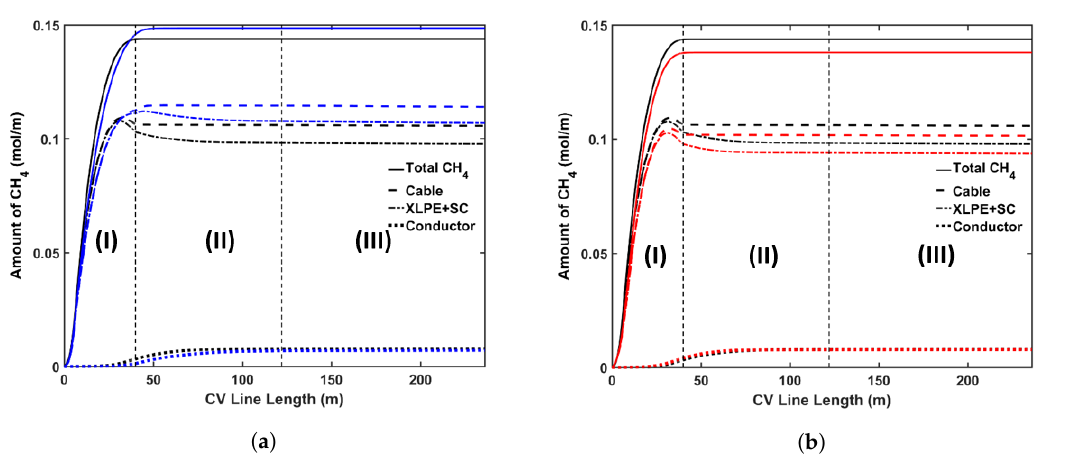
Figure 11. Axial CH 4 concentration profile across CV line for curing temperature study. The black line represents base case, blue line in ( a ) represents Case 1a, and red line in ( b ) represents Case 1b. Segment (I), (II) and (III) correspond to curing tube and transition zone, water cooling, and air cooling segments, respectively.